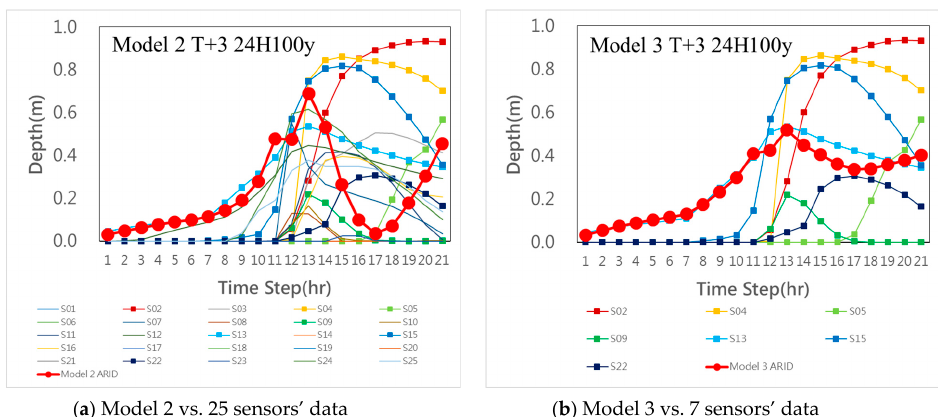
Figure 7. The sensor data vs. T + 3 forecasted average regional inundation depths by Models. ( a ) 25 sensors’ data vs. T + 3 forecasted ARIDs of Model 2; ( b ) 7 sensors’ data vs. T + 3 forecasted ARIDs of Model